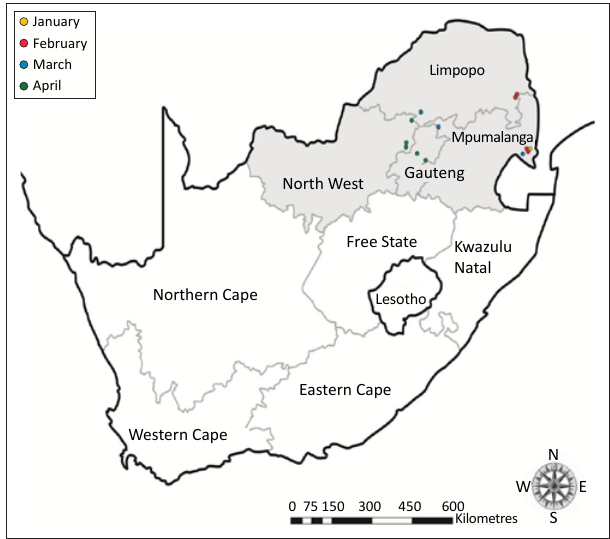
FIGURE 1: Reported Rift Valley fever outbreaks in domestic livestock and buffaloes in South Africa in